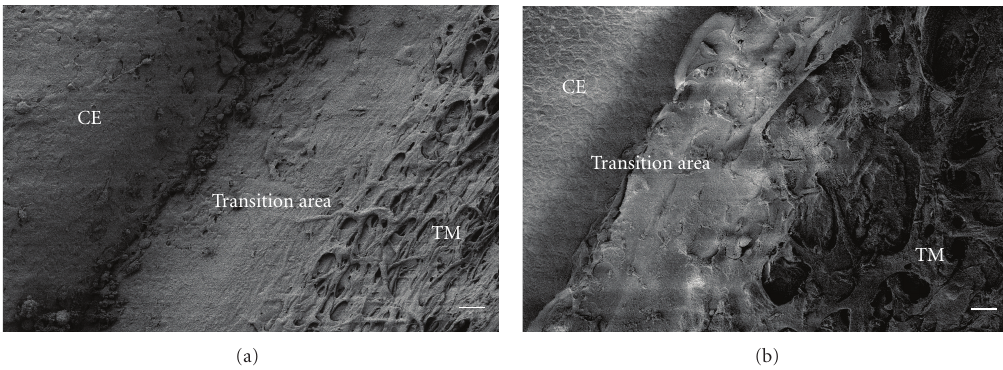
Figure 3: Scanning electron micrographs of (a) human and (b) bovine eyes, showing the transition between the peripheral cornea and anterior portion of the trabecular meshwork. There is a distinct transition area in the human tissue but the transition is more abrupt in the bovine one. The samples were coated with gold and imaged at an accelerating voltage of 4kV and a working distance of 8mm using a SE2 detector (Gemini LEO 1550 SEM). Scale bar = 20 μ